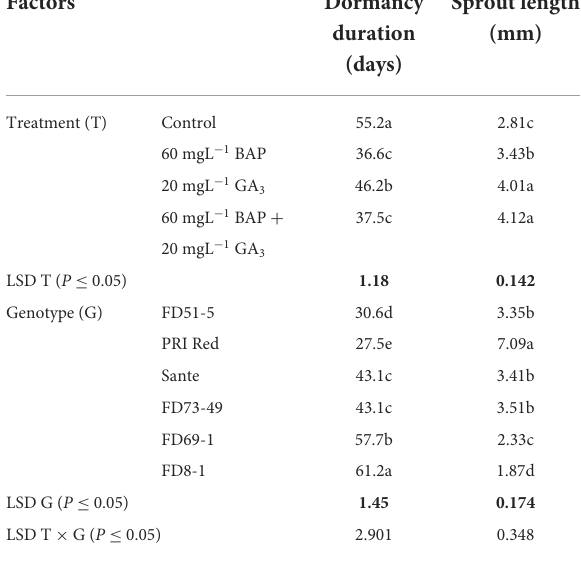
TABLE 2A Mean comparison of dormancy duration and sprout length of potato tubers dipped in optimized doses of PGRs and genotypes during